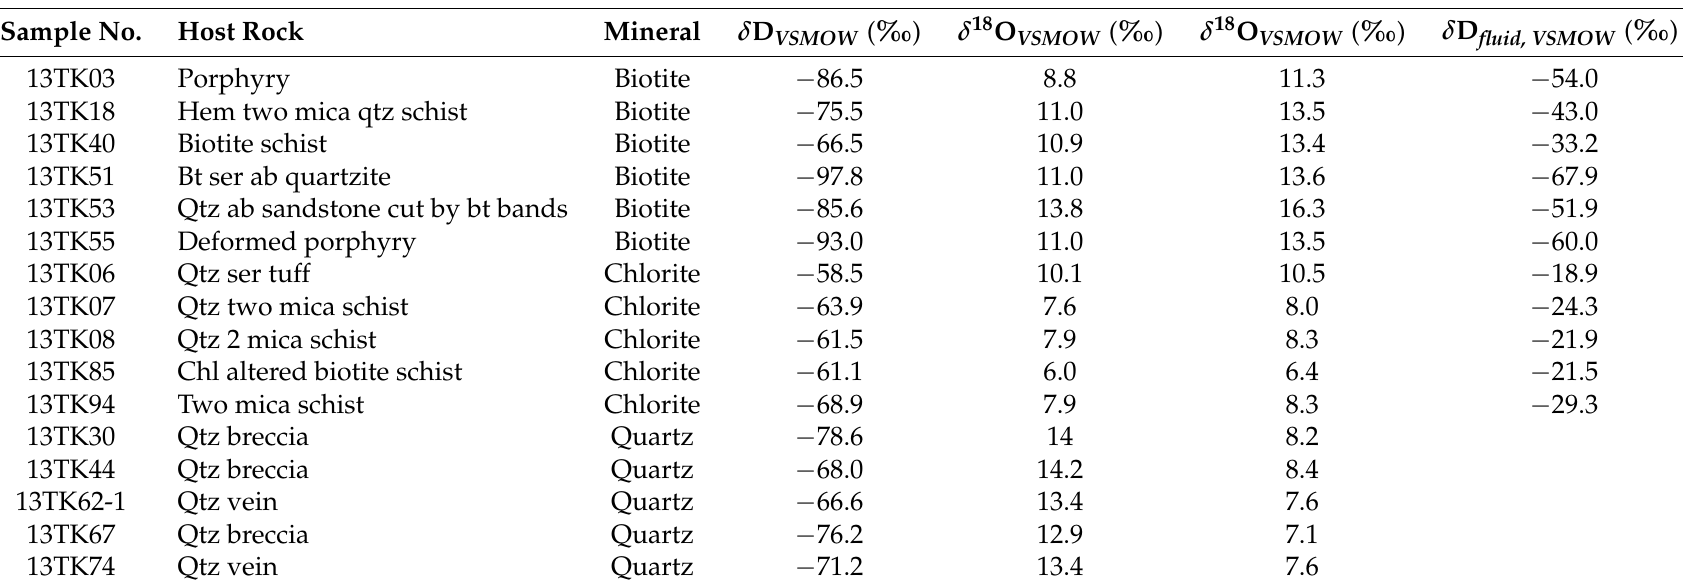
Table 3. Hydrogen and oxygen isotopic composition of biotite, chlorite, and quartz of the Tongkuangyu Cu deposit, North China Craton. Sample No.